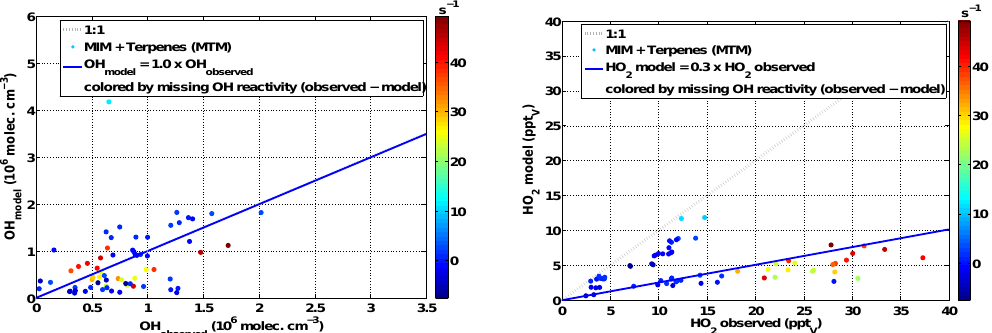
Fig. 11. Simulated vs. observed OH concentrations and HO 2 mixing ratios, applying the MIM2 chemistry scheme and the recently proposed MIM3 including new additions in the isoprene chemistry.